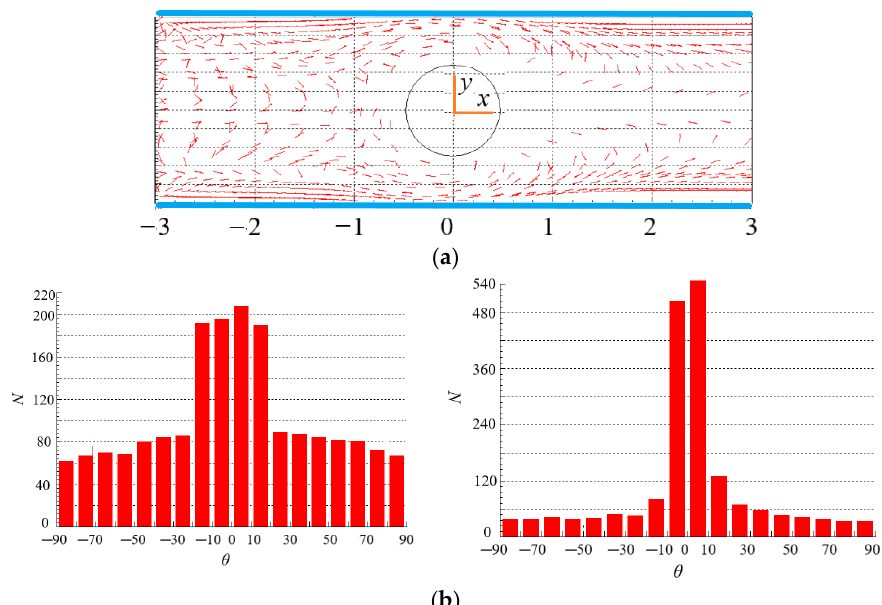
Figure 8. Spatial and orientation distributions of particles at Re = 200 ( n = 1, β = 8). ( a ) spatial distribution. ( b ) orientation distribution: left: contraction flow ( x < 0); right: expansion flow ( x > 0).